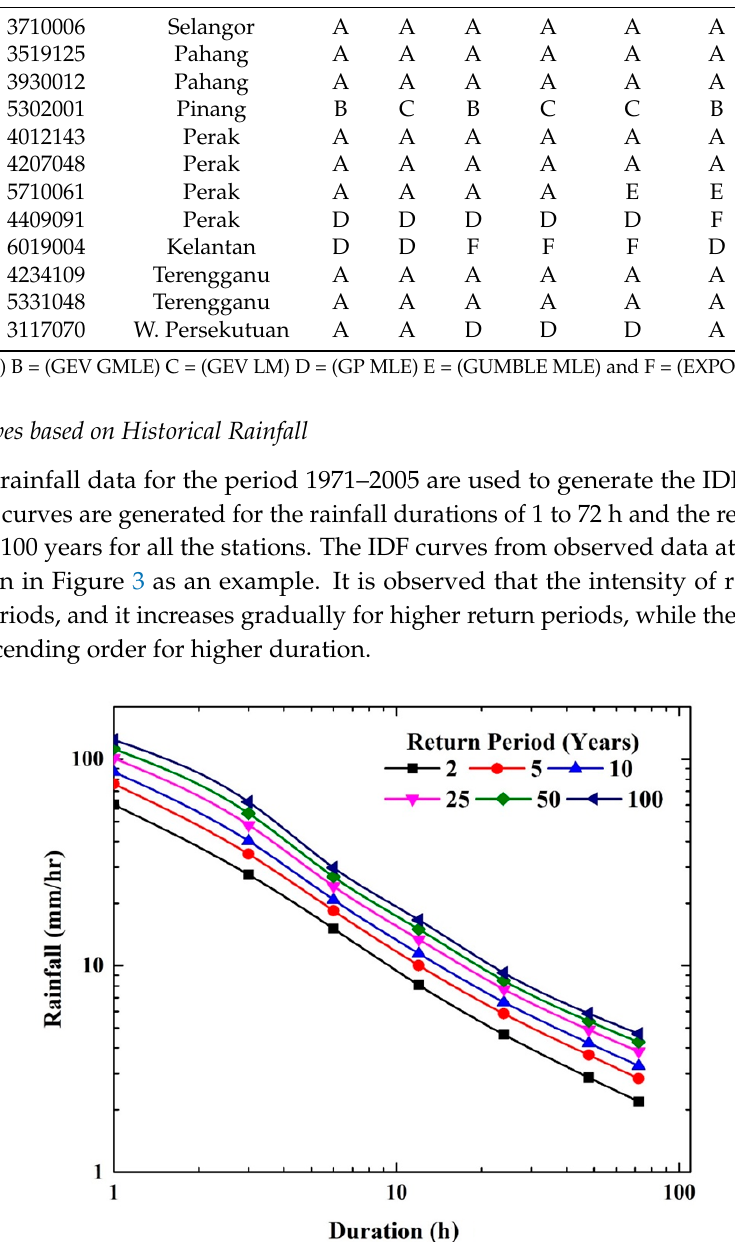
Figure 3. Historical IDF curves developed using GEV-MLE for observed (gauged) rainfall data